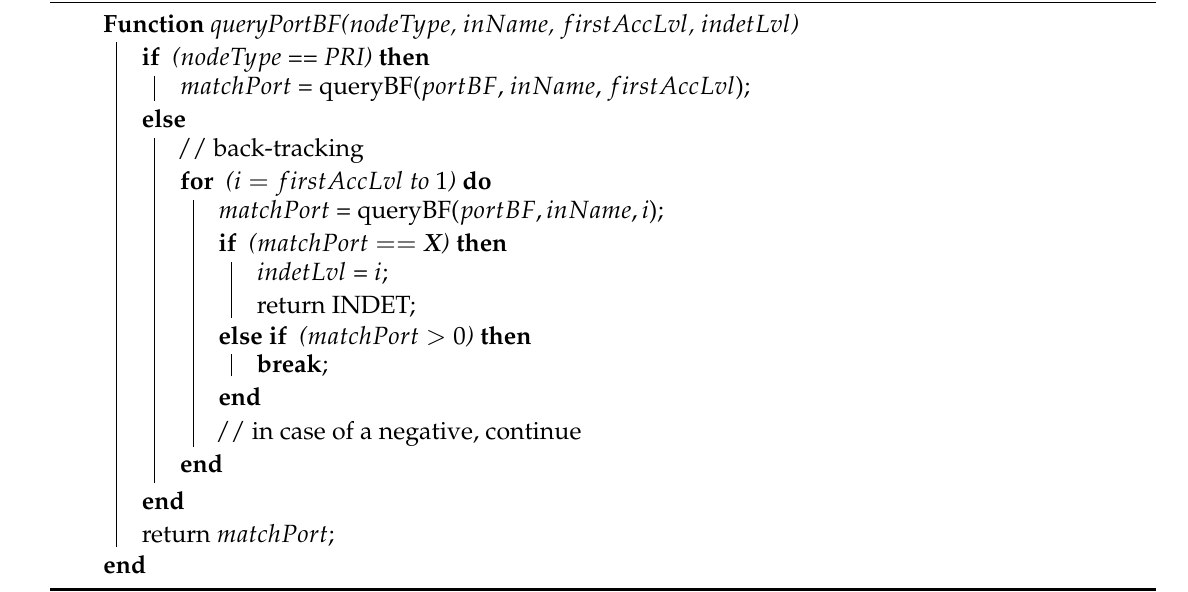
Algorithm 3: Querying Procedure of the p